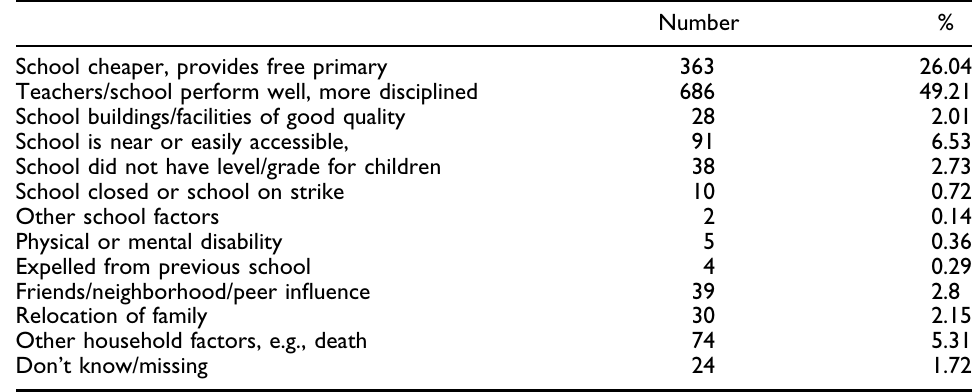
Table 2. Reasons for changing